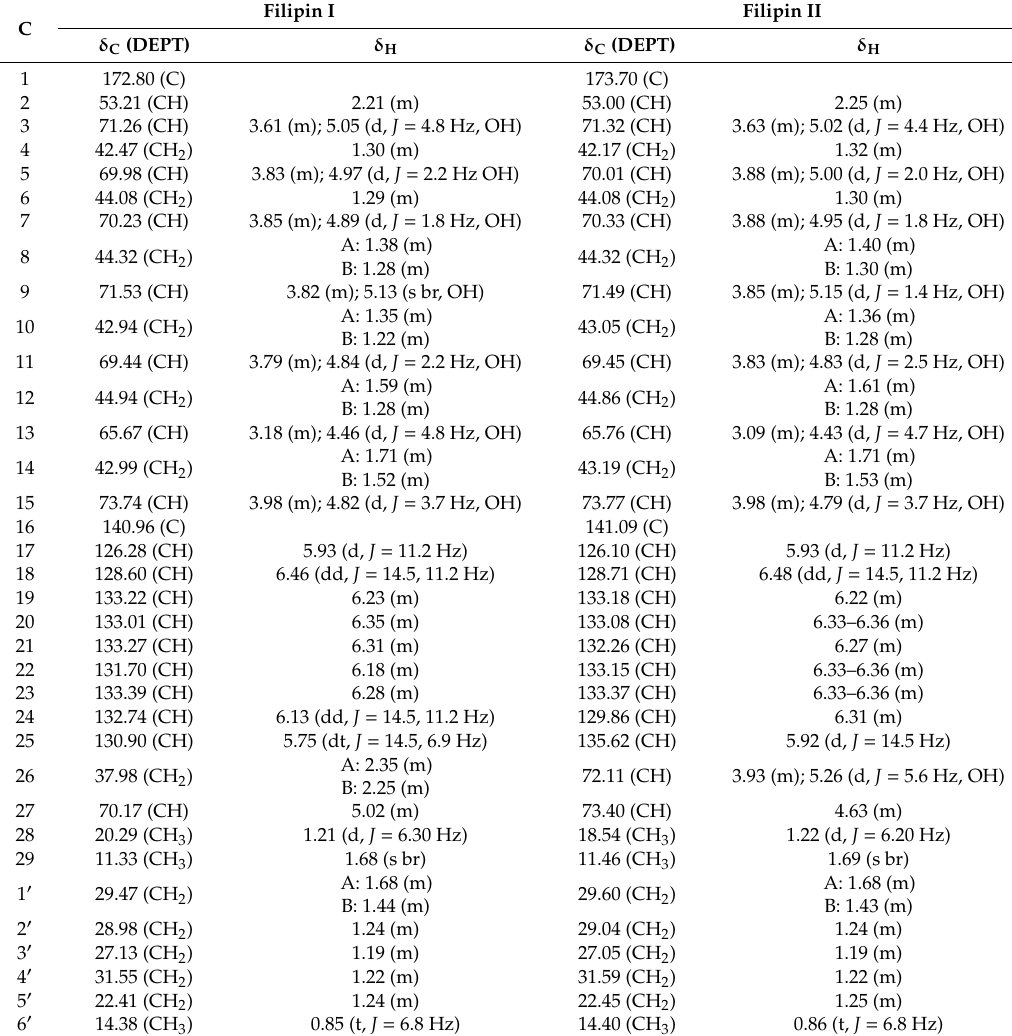
Table 1. 1 H and 13 C NMR chemical shifts assignments for filipin I and filipin II (DMSO-d 6